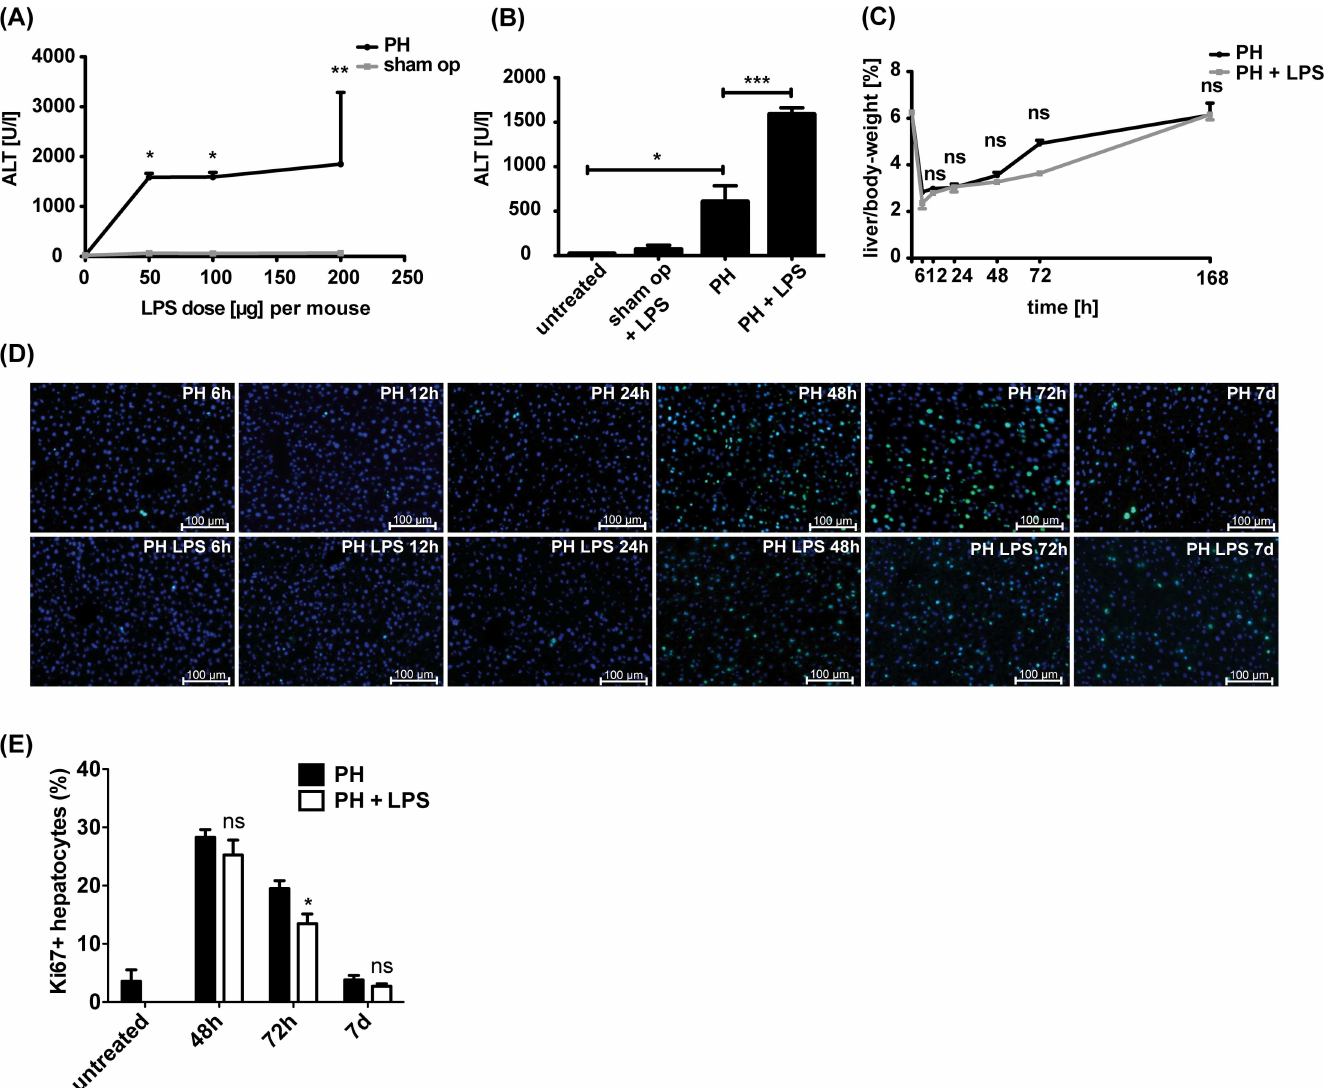
Fig 1. LPS dose-response profile and liver regeneration under low-dose LPS stimulus. WT mice underwent sham-operation or PH followedby intraperitoneal applicationof different doses of LPS. LPS dosage per 20g body weight is depicted. (A) Quantitative analysisof the liver specific enzyme alanine-aminotransferase (ALT) 24h post surgery (n = 3). (B) ALT serum levels in WT mice 24h after sham-operation or PH in absenceor presenceof 50 μ gLPS per 20g body weight are shown (n = 3). (C) Liver/body-weight-ratioin percent of WT mice at different time points upon PH or PH and LPS application.Seven days (168h) post surgery completeliver regeneration was observed. Graph represents mean ± SD from 3 mice for each setting. (D) Hepatocyte proliferationwithin the liver parenchyma at distinct time points post-PH or PH and LPS. Proliferating hepatocyteswere detected by Ki-67 (green) and nuclearDAPI (blue) using immunofluorescencestaining of liver cryosections. Liver sections of non-operated mice served as untreatedcontrol. Representative images are shown (n = 3 mice). Scale bars indicate 100 μ m.(E) Percentageof Ki-67 positive hepatocytesin relationto all hepatocyteswas quantified.Mean ± SD from at least 5 cryosectionsfor each time point from two mice (n (cid:21) 2000hepatocytes)is shown.